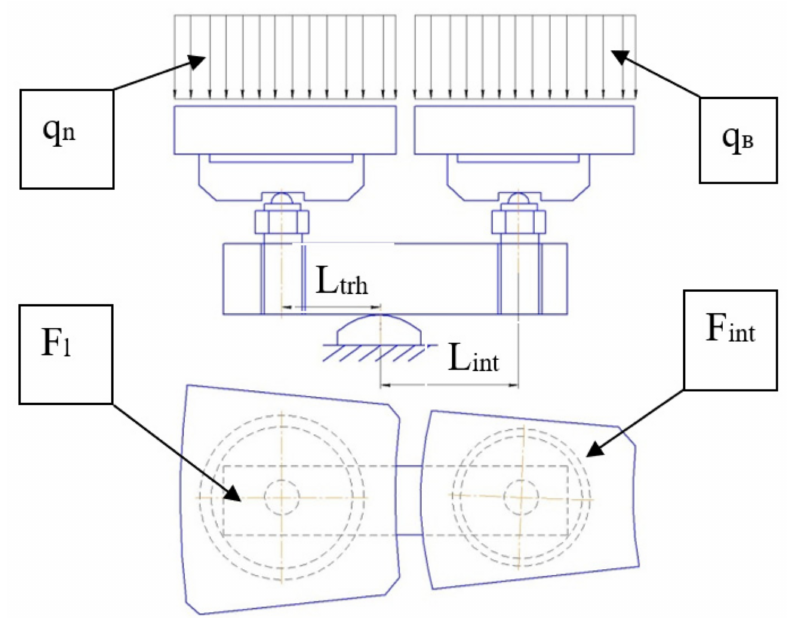
Figure 4. Loading Diagram of the double-row thrust bearing